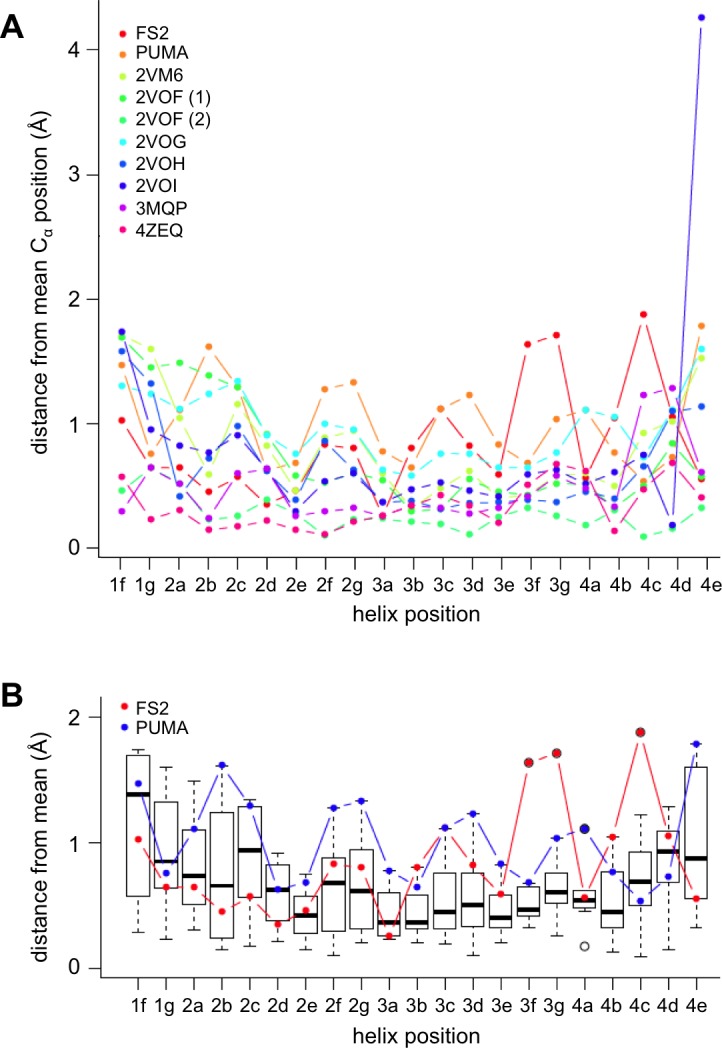
Comparison of PUMA and FS2 binding geometry with that in other crystal structures of BH3:Bfl-1 complexes deposited in the PDB.All Bfl-1:peptide structures were aligned to Bfl-1 and the mean C-alpha positions were calculated for each BH3 peptide position. Mean distances were calculated separately for all complexes in the asymmetric unit. (A) The C-alpha distance deviation from the mean is plotted for all structures. (B) Box plots illustrate the positional variability at each site. FS2 is significantly shifted at peptide positions 3f, 3g and 4c. The following structures from the PDB were included in this comparison: 2VM6 (Herman et al., 2008), 2VOF (Smits et al., 2008), 2VOG (Smits et al., 2008), 2VOH (Smits et al., 2008), 2VOI (Smits et al., 2008), 3MQP (Guan et al., 2010 in press) and 4ZEQ (Guan et al., 2005).